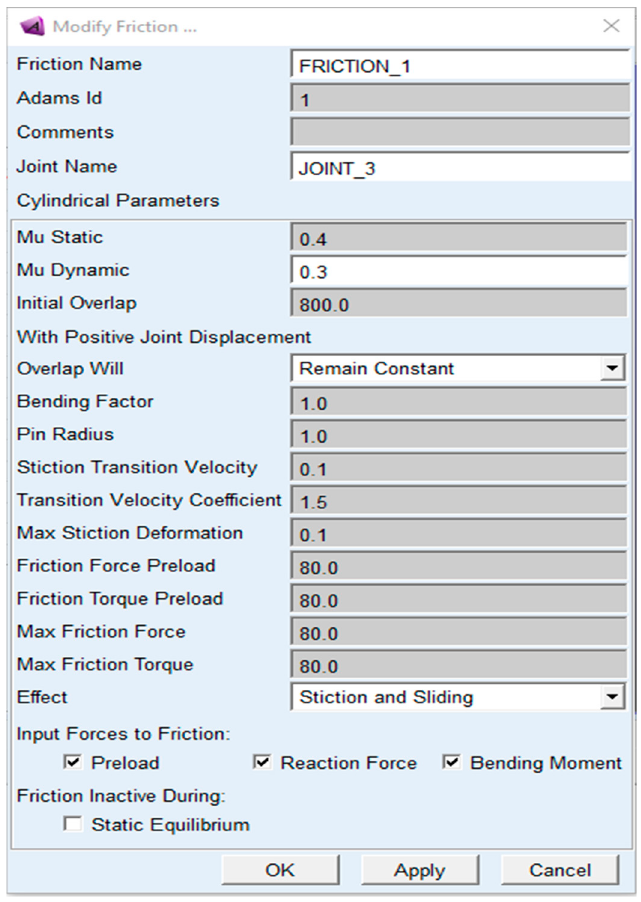
Figure 5. Parameters for friction multibody model.